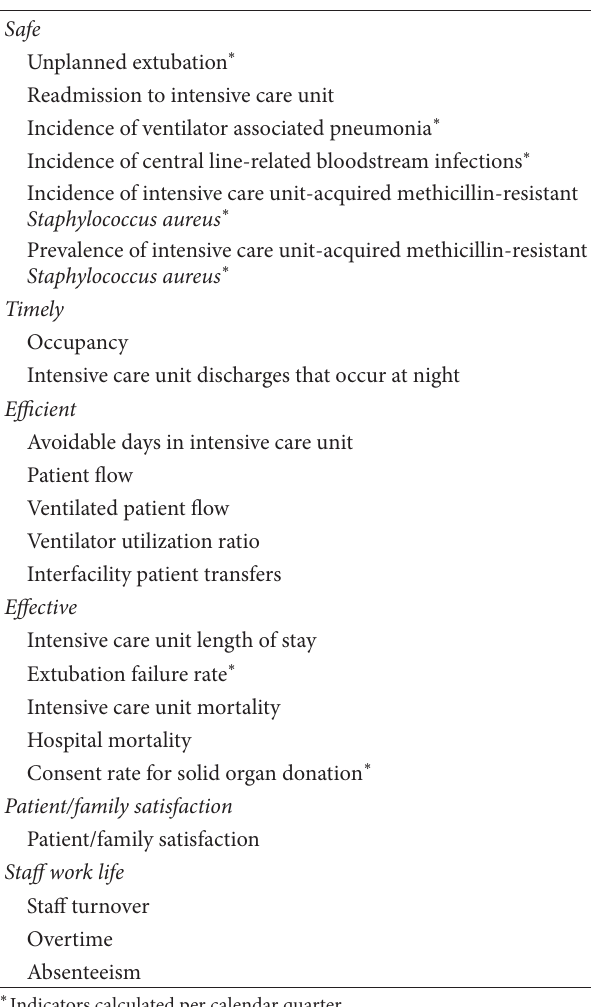
Table 1: Quality indicators and their